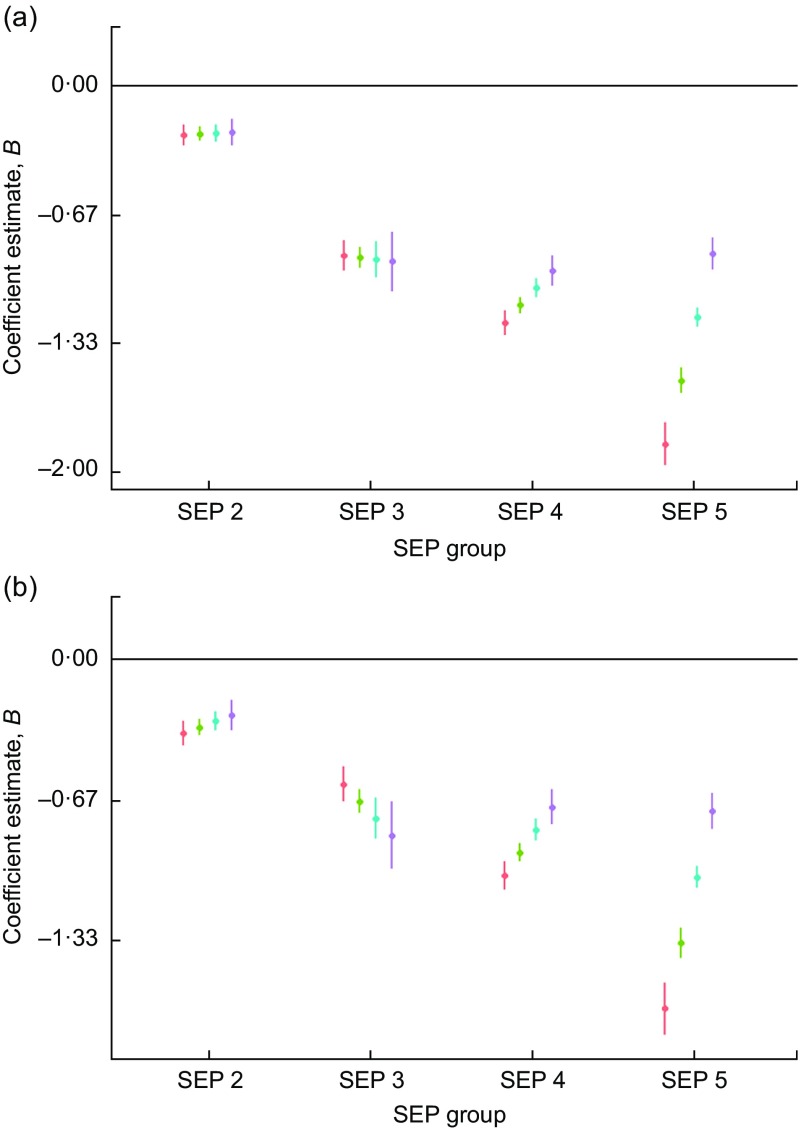
Regression estimates of (a) male and (b) female grip strength size Z-scores (dots) with 95 % CI (whiskers) across socio-economic position (SEP) groups (2–5), with SEP 1 as reference group (horizontal line at 0), by decade of birth centred on 1960 (), 1970 (), 1980 () and 1990 (), for children and adolescents (n 40 484) aged 3–19 years of Ladino and Maya ancestry born during 1955–1993 in Guatemala (n
observations 157 067). The plots were created using R packages ggplot2, broom, jtools, dotwhisker and dplyr (see the online supplementary material for references)